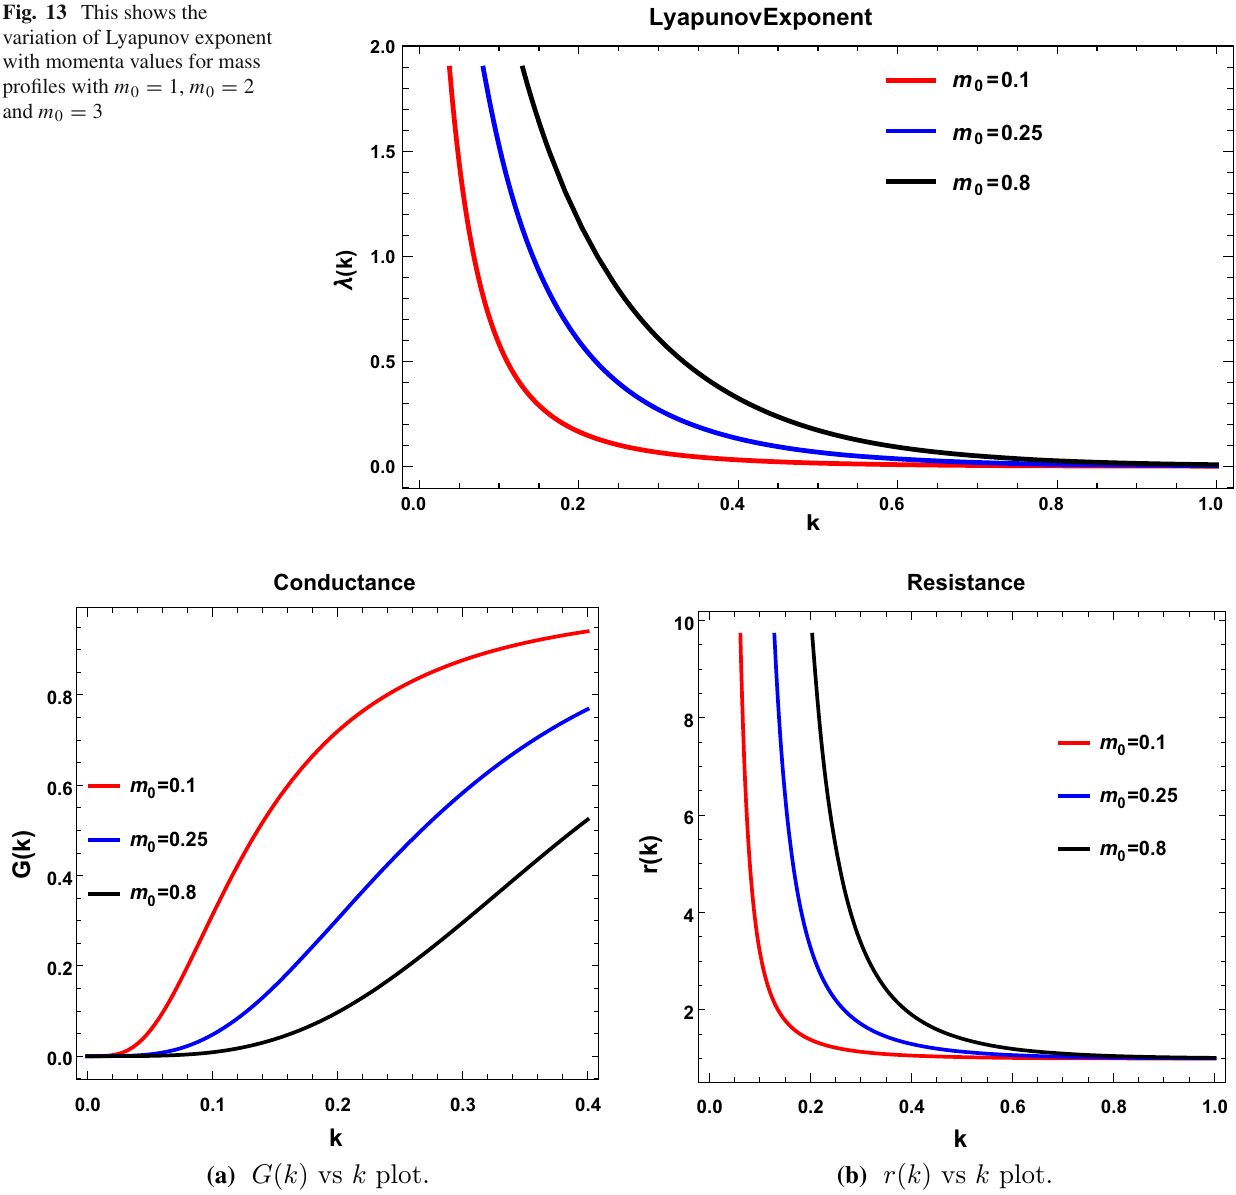
Fig. 14 Wave number dependence of conductance and resistance for the mass profile II is shown here. Here we fix ρ = 1